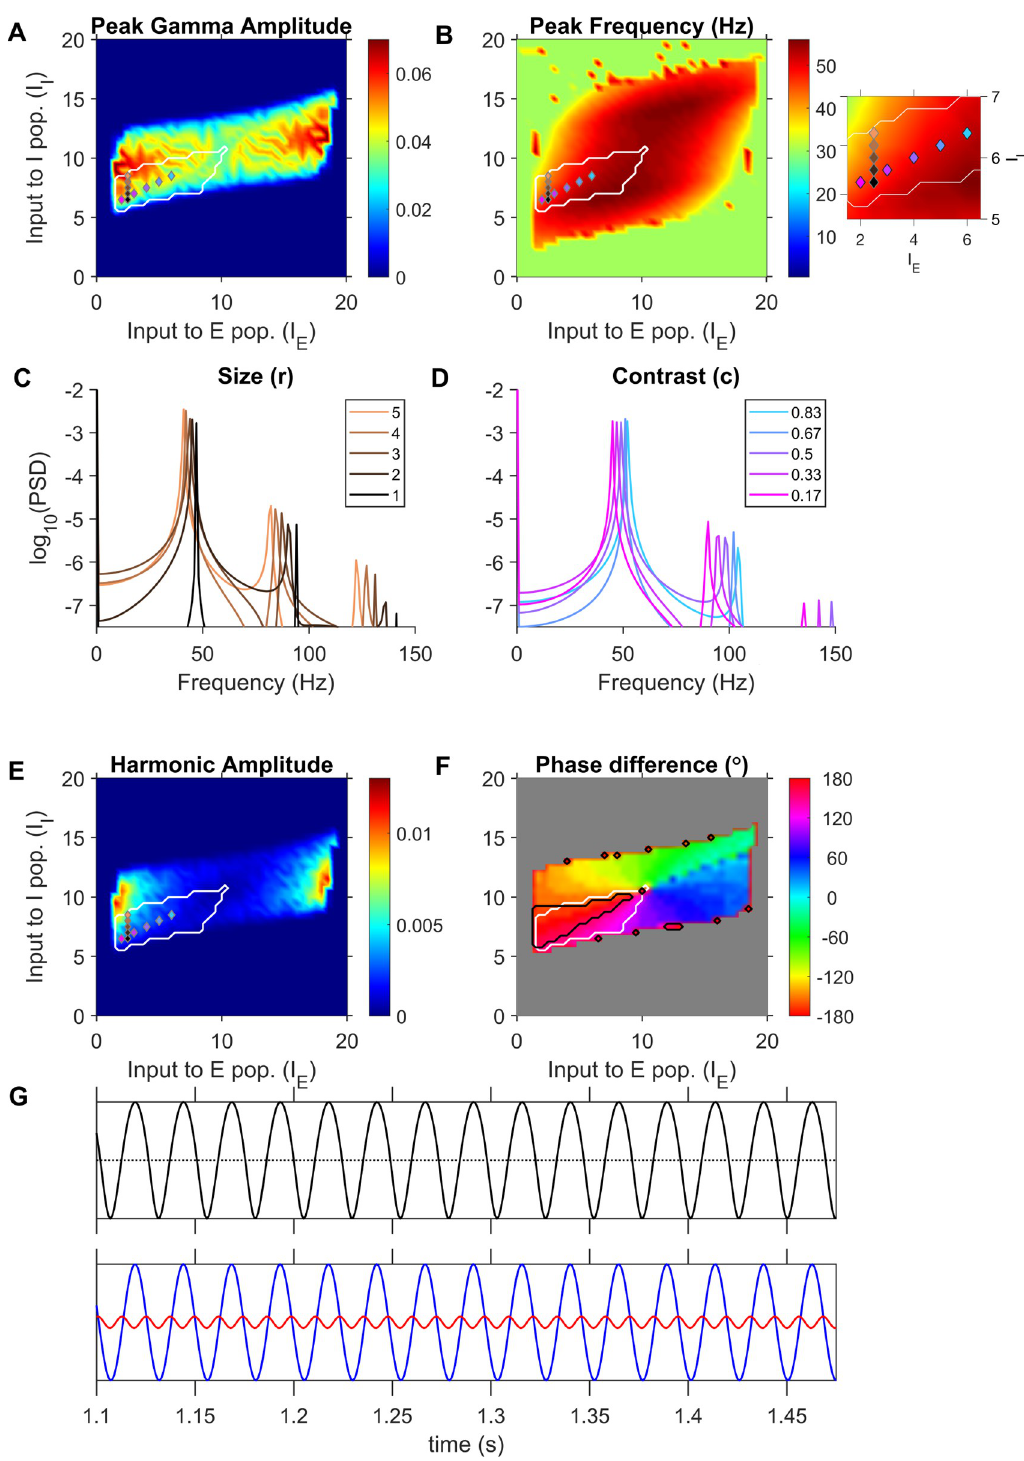
Fig 7. JS model produces sustained arch-shaped gamma oscillations within the previously identified superlinear inhibitory regime. (A) Peak gamma amplitude and (B) Peak gamma frequency in the LFP proxy generated by the JS model for each input- drive combination. (C) PSD of LFP proxy generated for different stimulus sizes. (D) PSD of LFP proxy generated for different contrast. Input combinations used in (C) and (D) are indicated by markers, with same colors as traces, in (A), (B) and (E). The Inset on the right of (B) shows the same plot over a more restricted range for better visualization of input combinations.